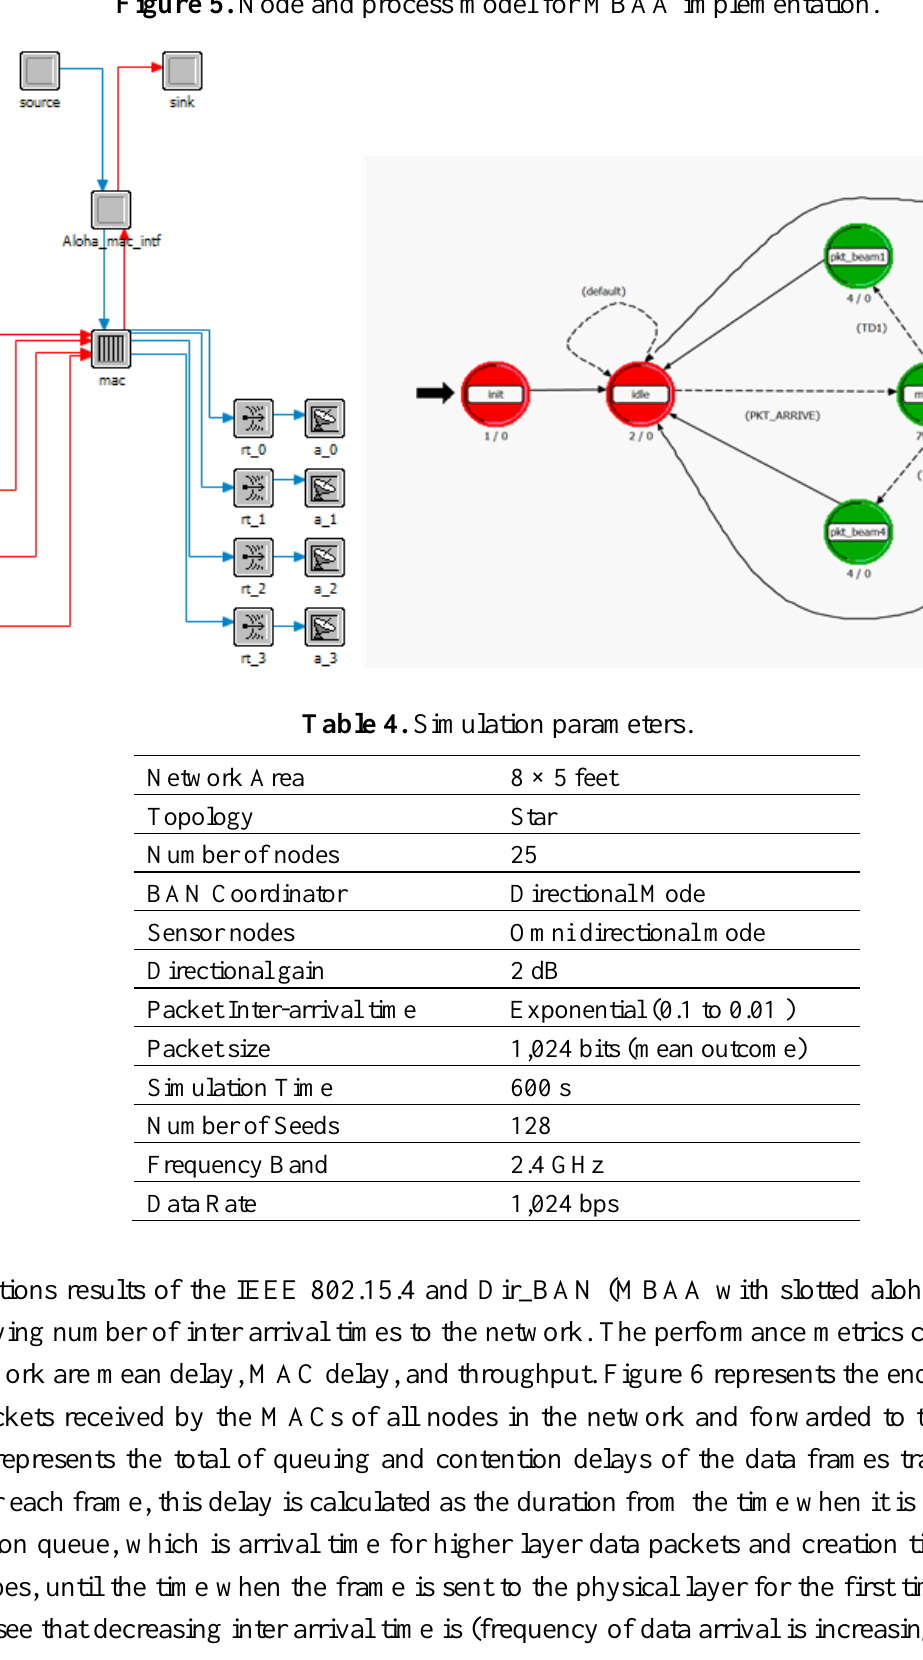
Figure 5. Node and process model for MBAA implementation.